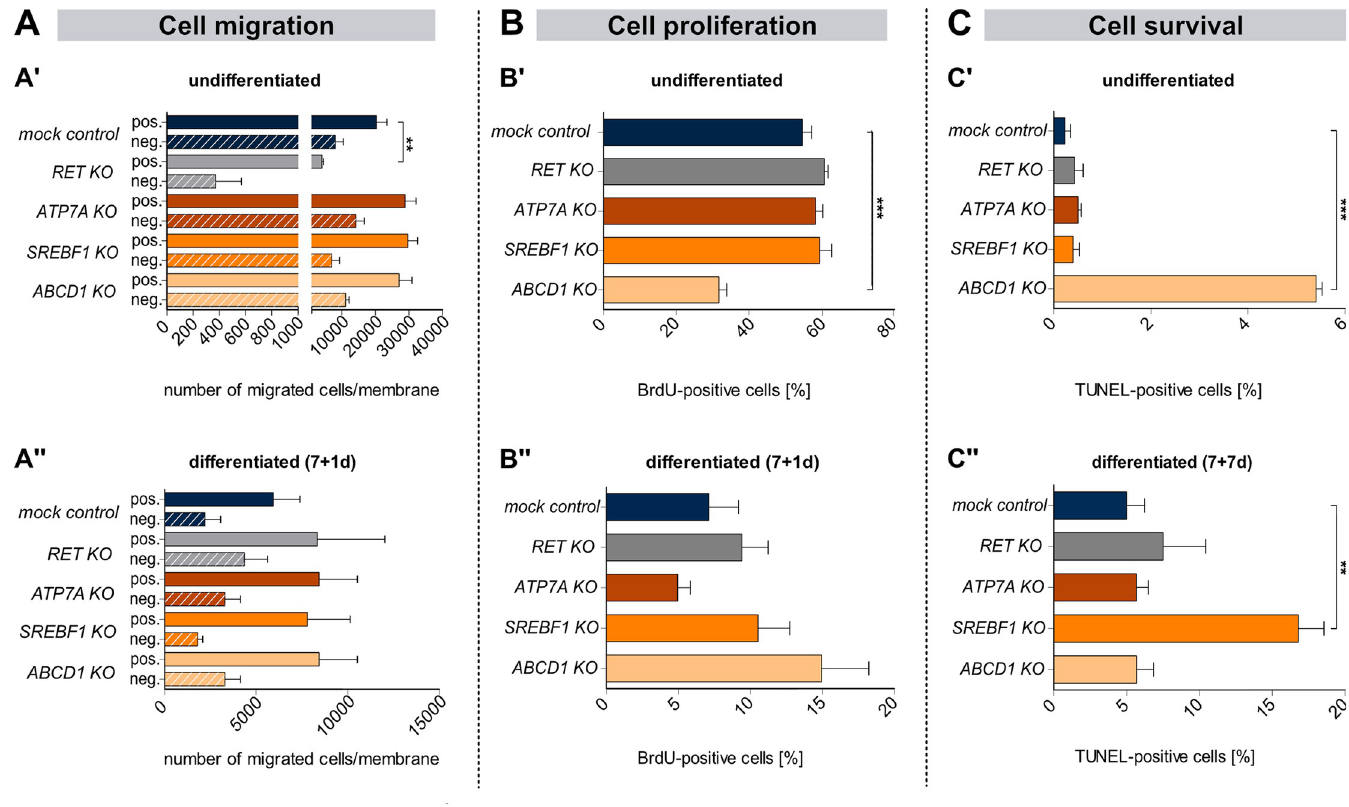
Fig 4. Comparative functional analyses of all genome-engineered clones. (A) Cell migration in undifferentiated (A ' ) and differentiated (7+1d) (A") cell clones was measured by Boyden chamber assays. In the positive control, FBS was applied as a chemoattractant for undifferentiated cells and BDNF was applied as a chemoattractant for differentiated cells (negative: basal medium only). (B) The proliferation capacity of undifferentiated (B ' ) and differentiated (7+1d) (B") genome- edited clones was assessed by a BrdU assay. (C) The number of apoptotic cells in undifferentiated (C ' ) and differentiated (7+7d) (C") clones was determined by a TUNEL assay. (A-C) All functional analyses were compared with the mock control clone. Bar plots show mean + standard error of mean (SEM) (n � 3). One-way ANOVA, Bonferroni corrected, � p < 0.05; �� p < 0.01; ��� p < 0.001. Undiff: undifferentiated.